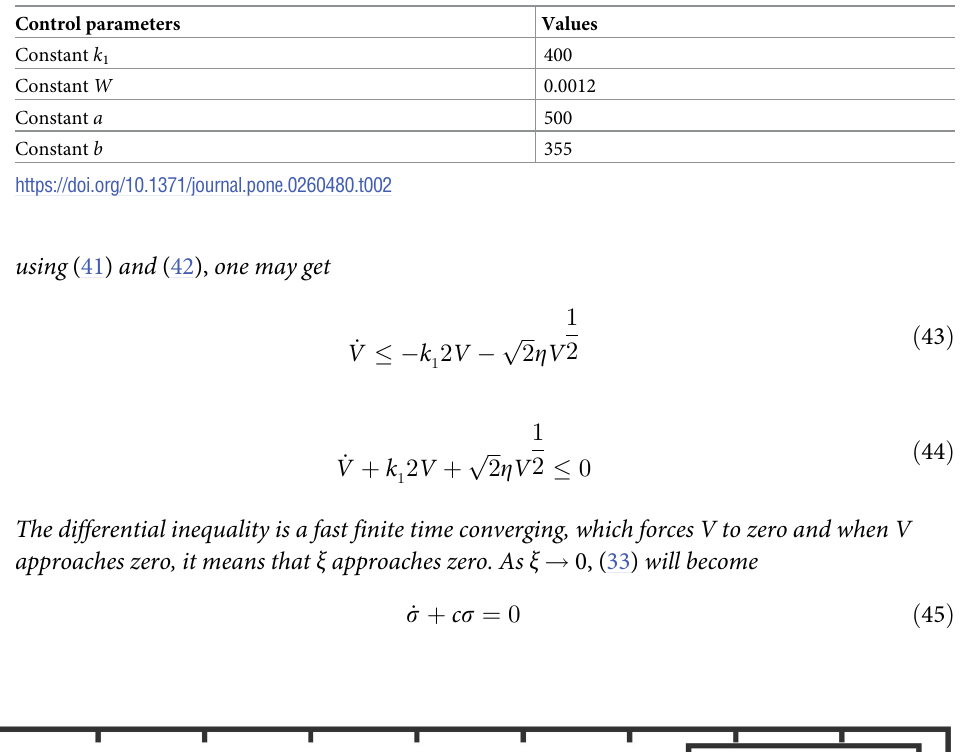
under varying irradiance. ref